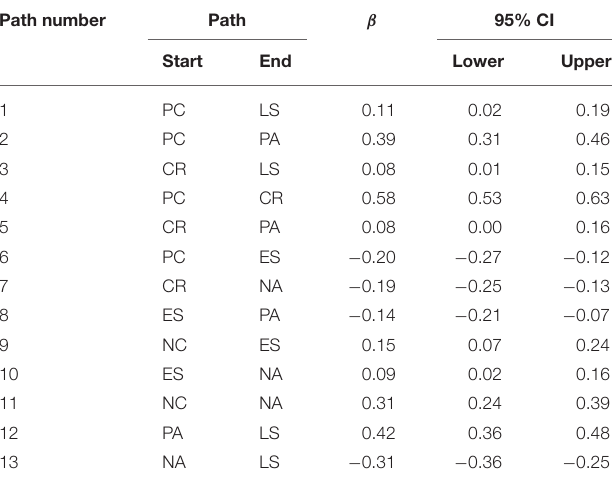
TABLE 4 | Parameter description of paths in structural equation modeling (SEM). Path